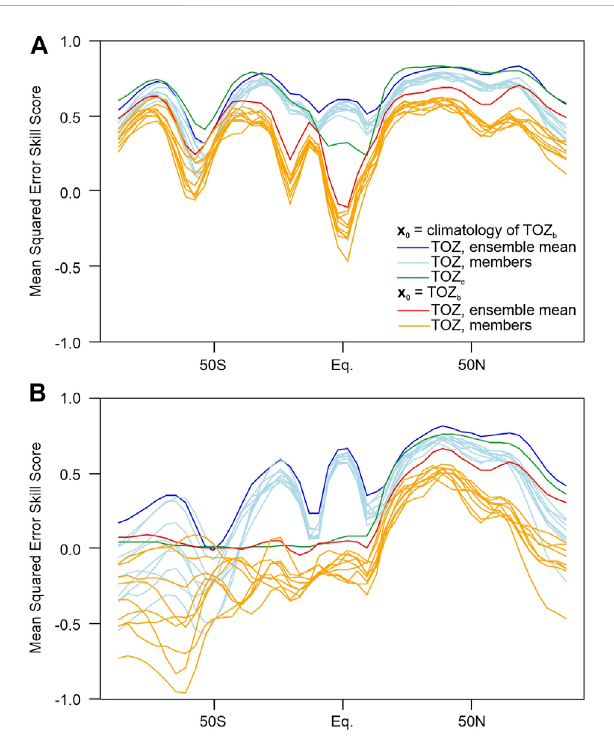
Results of the evaluation in terms of the MSESS (A) , full network (B) , and sparse network mimicking 1942, with seven stations, all in the Northern